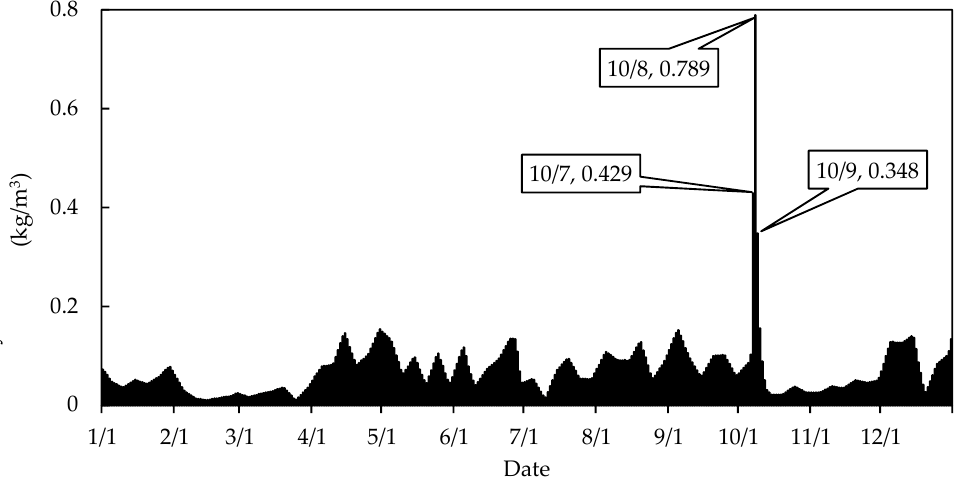
Figure 10. The daily mean sediment concentration provided by the Gangkou Station.